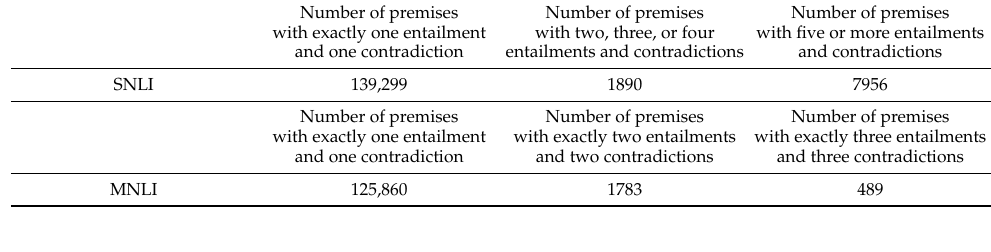
Table 1. SNLI [43] and MNLI [44] statistics based on the number of entailment and contradiction hypotheses for each premise sentence.